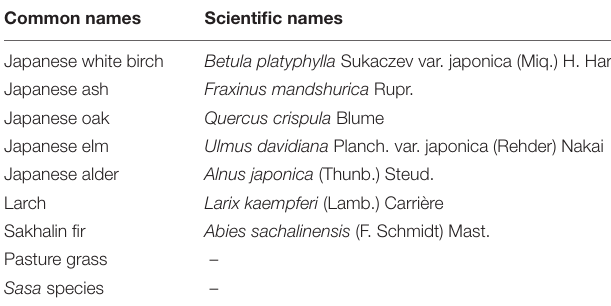
TABLE 2 | List of simulated